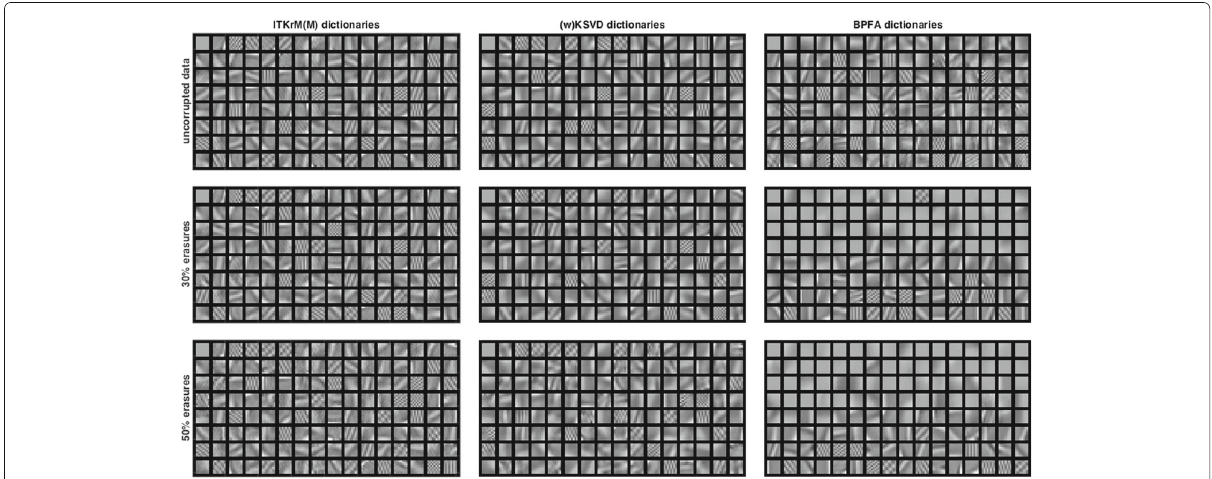
Fig. 5 Dictionaries and low-rank atom (left upper corner) learned with ITKrM(M) (left), (w)KSVD (middle) and BPFA (right) algorithms on all 8 × 8 patches of Barbara without corruption (top), 30% erasures (middle) and 50% erasures